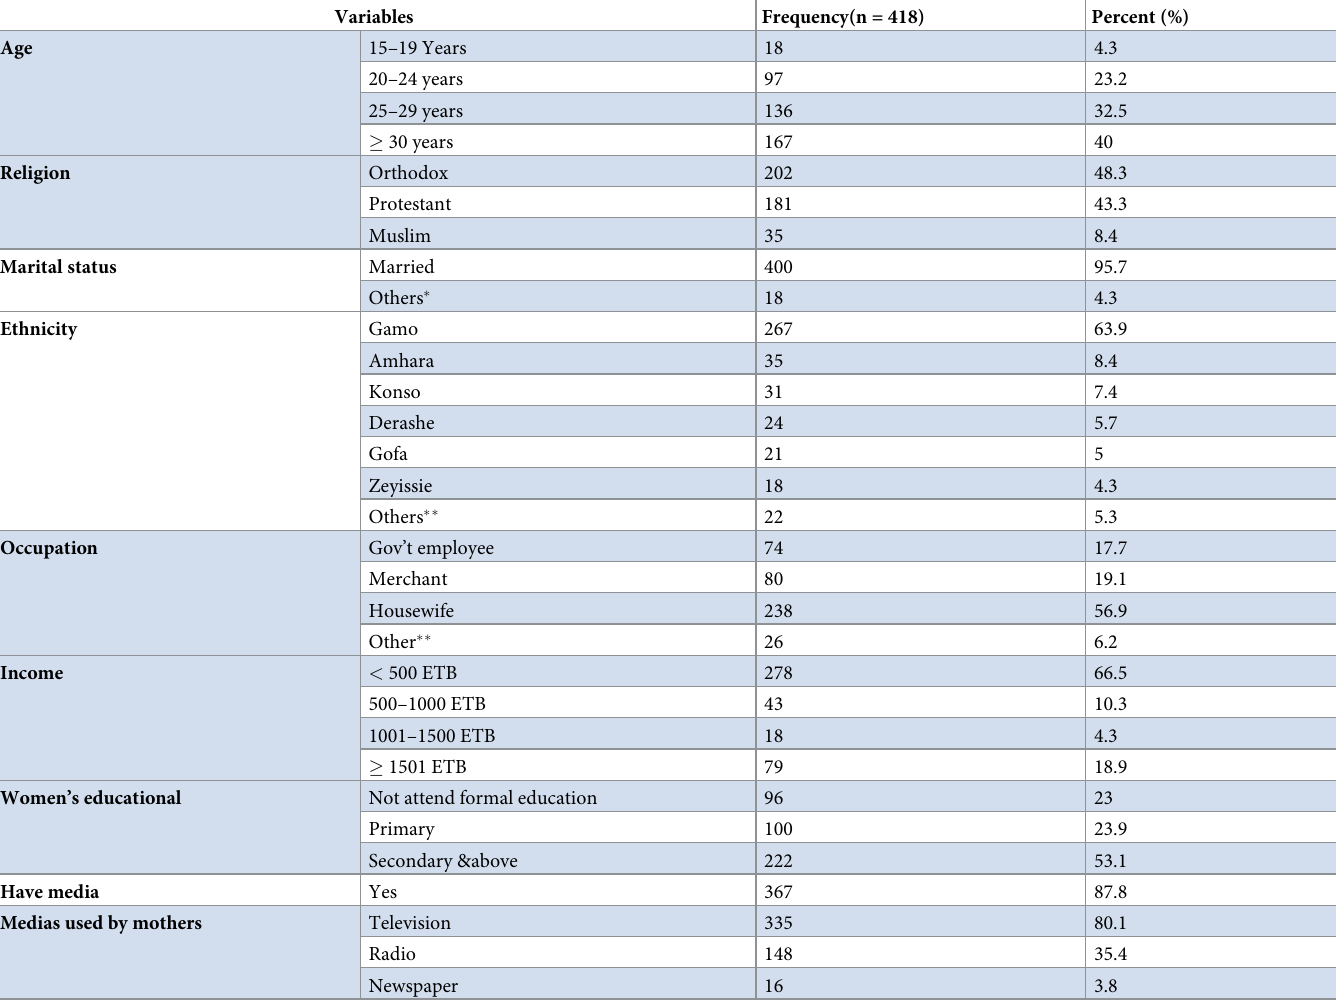
Table 1. Sociodemographic characteristics of the respondents in Arba Minch town, Southern Ethiopia, December 2019 (n =